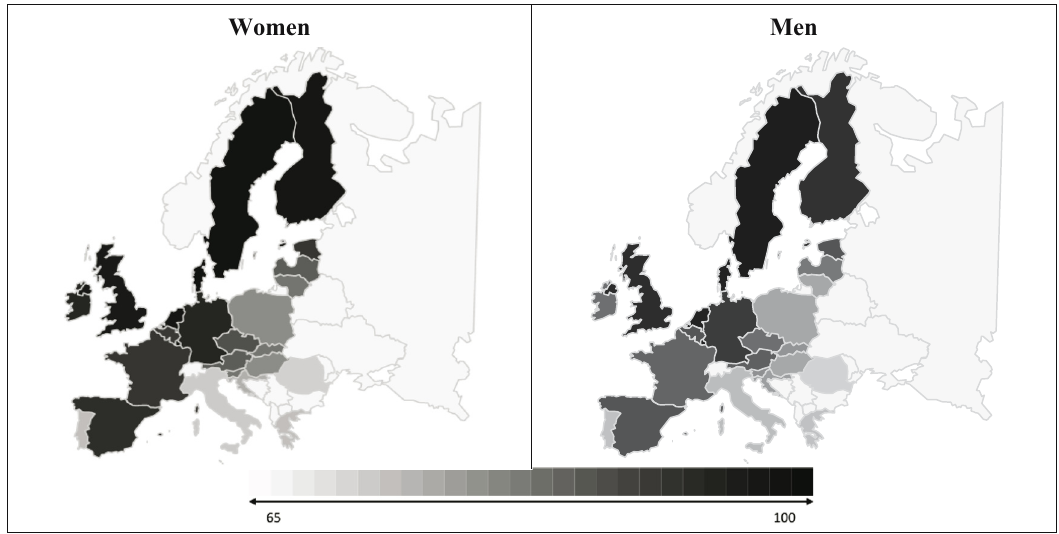
Figure 1: ICT - USE indicator in the EU - 28, 2019 ( % ) Note: Cyprus has the same color as Malta, both for men and women. Source: Own elaboration based on the Digital Economy & Society Database ( Eurostat ) and using Clearly and Simply ( https://www.clearlyandsimply.com/ clearly_and_simply/2009/06/choropleth - maps - with - excel.html )